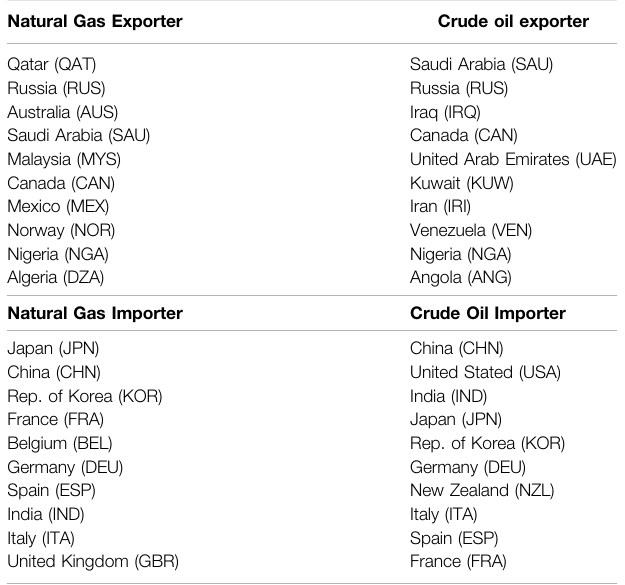
TABLE 1 | Top 10 trade country by subject, for each category ranking, is presented in a descending order.